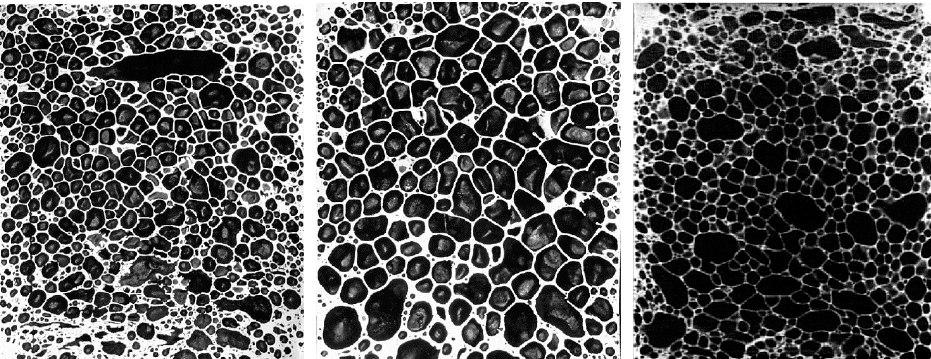
Figure 9. Foam pore structure, alloy variants AlSi7 with “as received” TiH 2 as foaming agent (left), thermally treated TiH 2 as foaming agent (center), “as received” TiH 2 as foaming agent and Ti/TiB 2 modification (right). Left and center image represent scans of cut samples, while the right image is derived from computer tomography (CT) data.